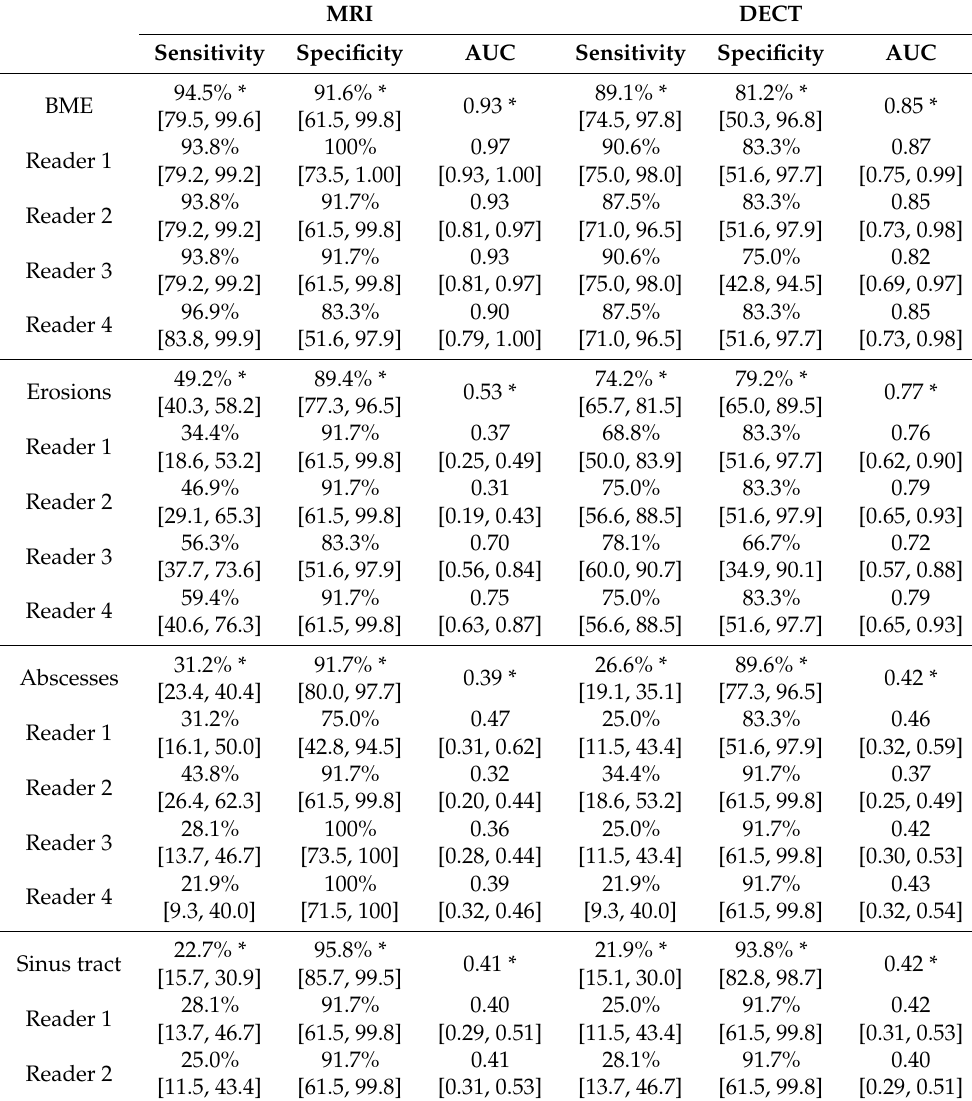
Table 4. Diagnostic performance of four readers at DECT versus MRI for diagnosing presence of BMEs, erosions, abscesses, sinus tracts, and